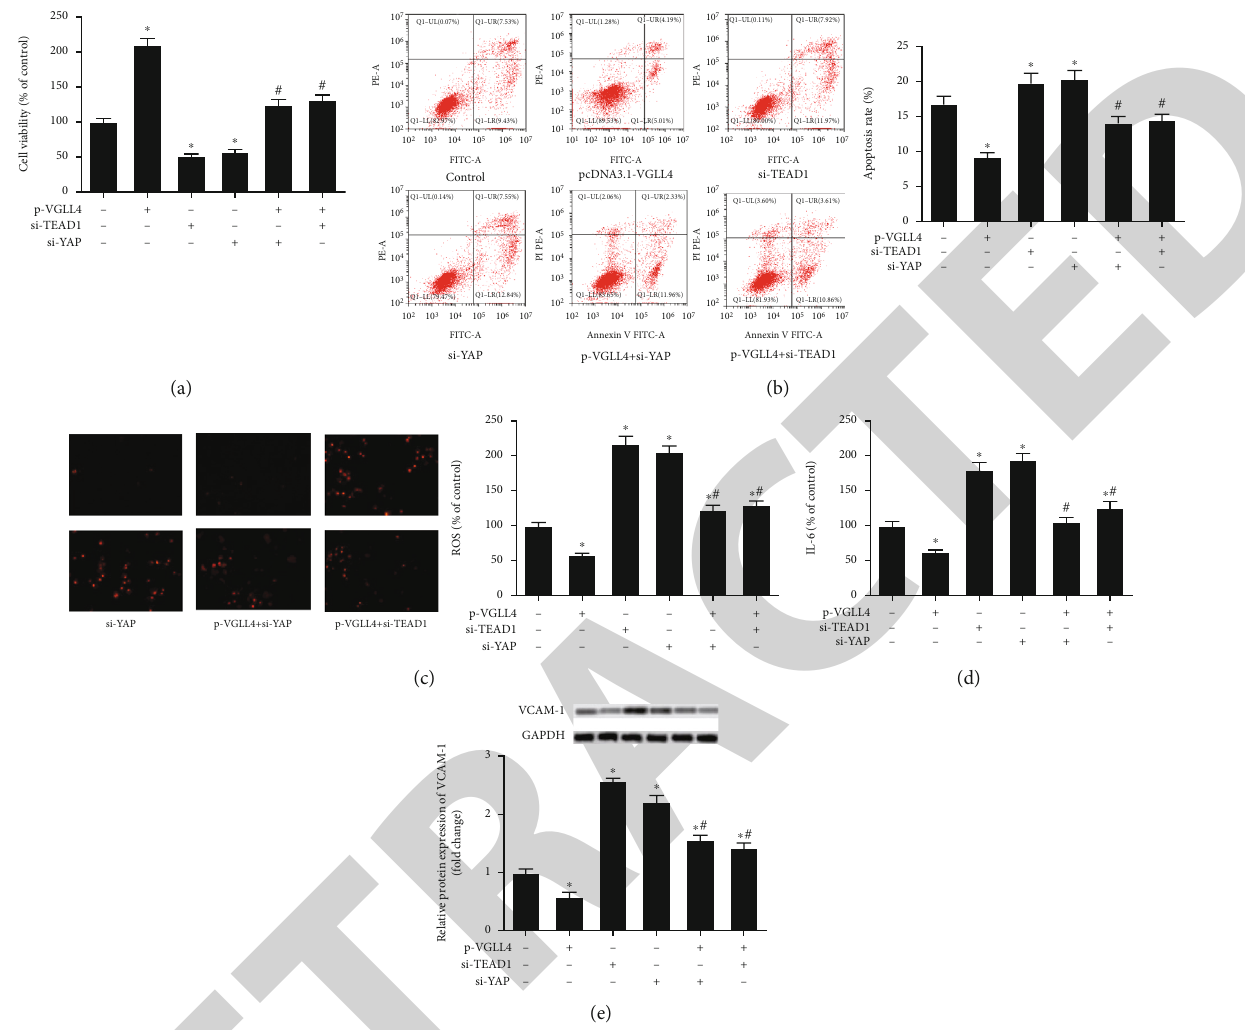
Figure 6: The Hippo YAP/TEAD1 signaling pathway is involved in the protective mechanism of VGLL4 on HUVECs. The HUVECs were treated with Ox-LDL (100 μ g/mL) for 24h and transfected with pcDNA3.1-VGLL4, si-TEAD1, or si-YAP, respectively. (a) The cell viability in each group. (b) The apoptosis of HUVECs in each group. (c) The ROS level in each group. (d) The IL-6 level in each group. (e) The protein expression of VCAM-1 in each group. “ ∗ ” means compared with the control group at P < 0 : 05 , and “ # ” means compared with the pcDNA3.1- VGLL4 group at P < 0 : 05 . GAPDH was used as an invariant internal control for calculating protein fold